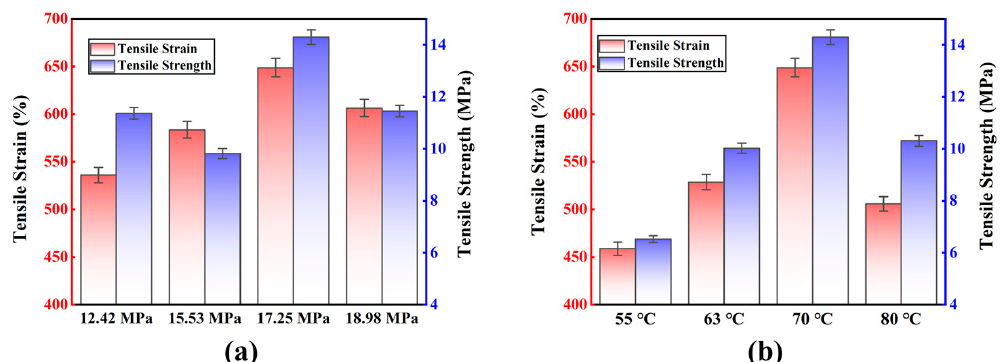
Figure 5. Tensile strain and strength results of polyurea under different conditions: ( a ) Different spraying pressures under the 70 °C; ( b ) Different spraying temperatures under the 17.25 MPa.